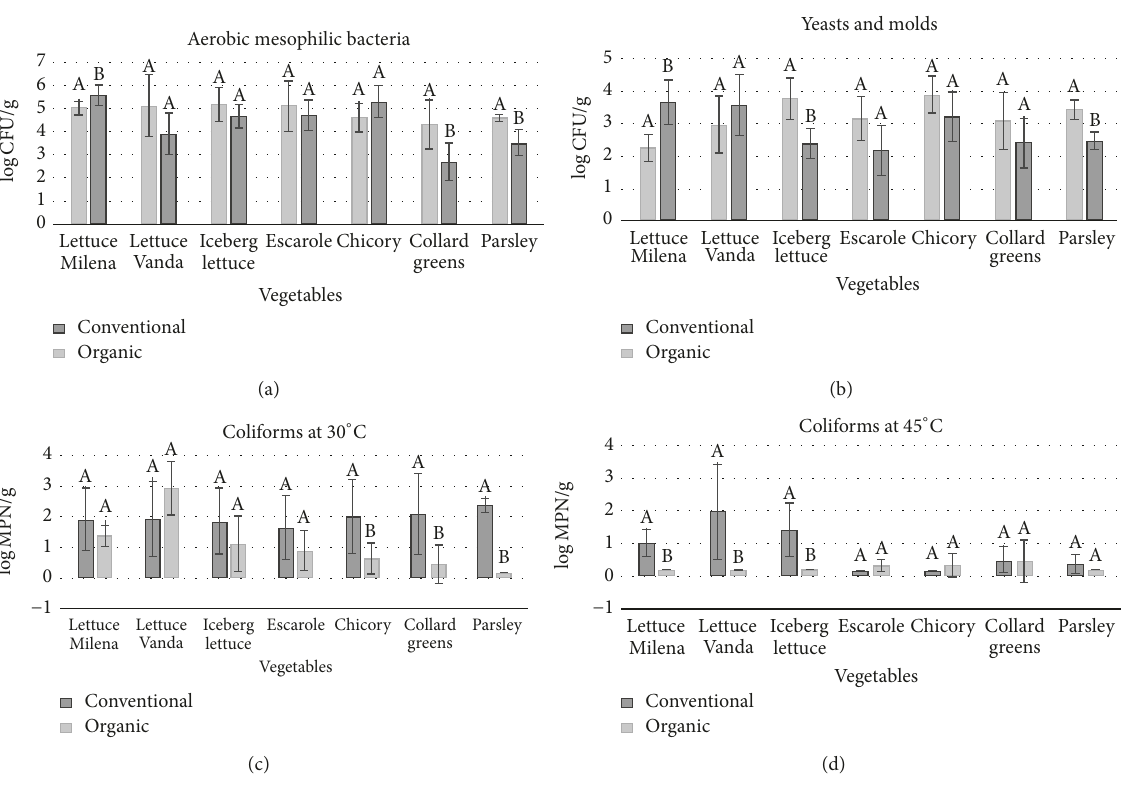
Figure 1: Counting of aerobic mesophilic bacteria (a), yeasts and molds (b), and coliforms at 30 ∘ C (c) and 45 ∘ C (d) among the 7 species of organic and conventional vegetables. Equal letters for the same vegetable indicate no statistical difference in Student’s 𝑡 -test ( 𝑝 < 0.05